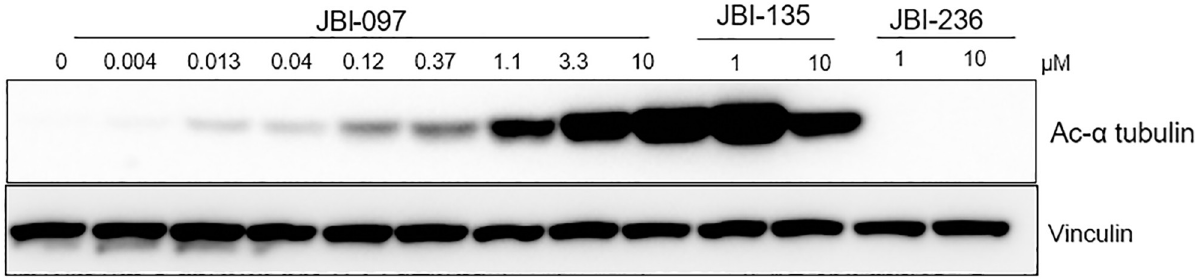
Fig 4. JBI-097 inhibition increased tubulin acetylation in HEL92.1.7 cells. HEL 92.1.7 cells were cultured with vehicle control, JBI-097 (3fold— 8point dose response from 10 μ M), Ricolinostat (10, 1 μ M) and Iadademstat (10, 1 μ M) for 3 h. Whole-cell lysates were subjected to immunoblotting with the indicated antibodies. Vinculin was used as loading